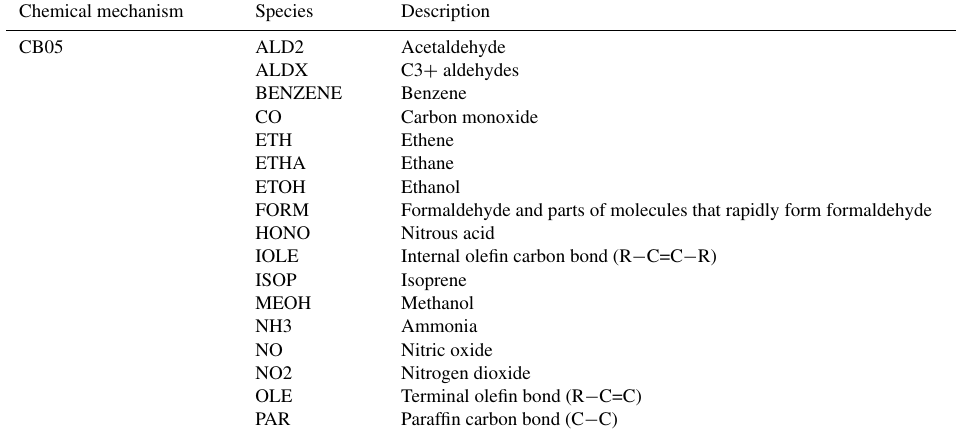
Table A2. Description of the species included in the CB05, RADM2, AERO5 and MADE-SORGAM chemical